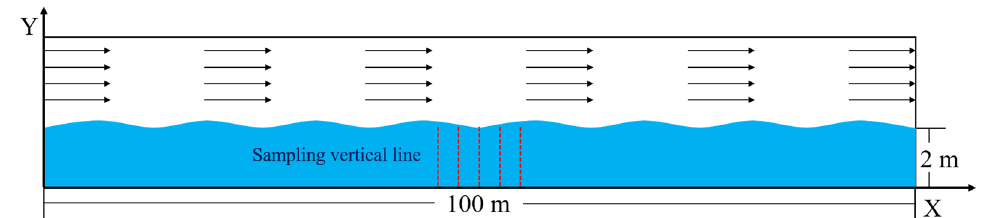
Figure 1. Schematic diagram of the mathematical model for wind-driven current